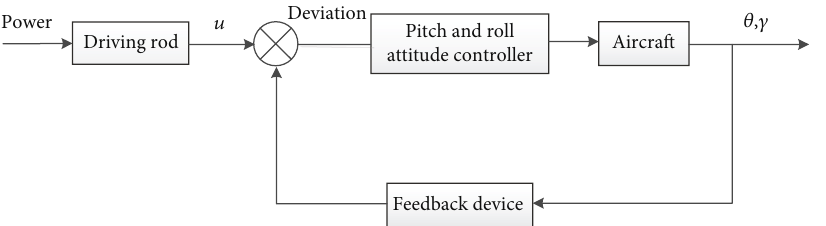
Figure 2: Aircraft attitude control system.